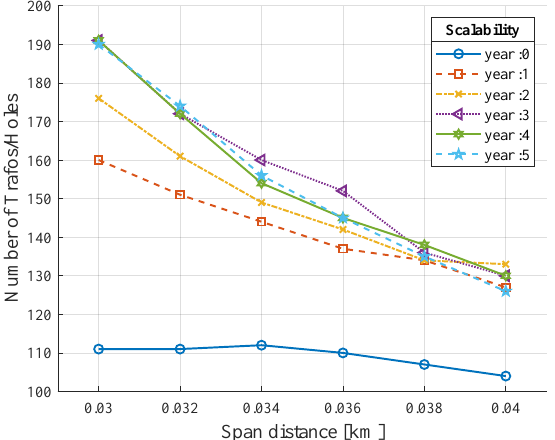
Figure 8. Evaluation of the model with scalability in six years.